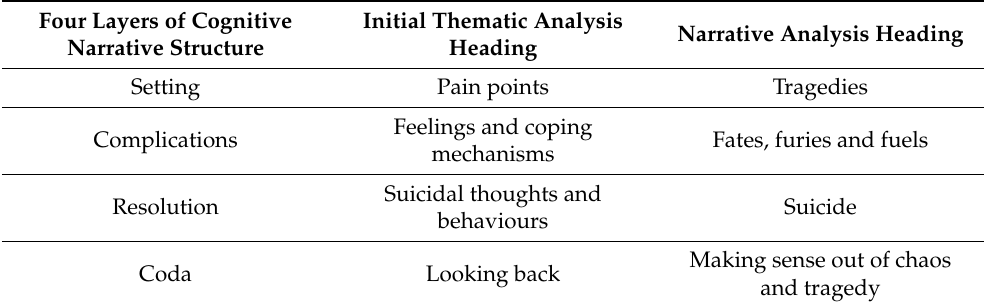
Table 2. Narrative